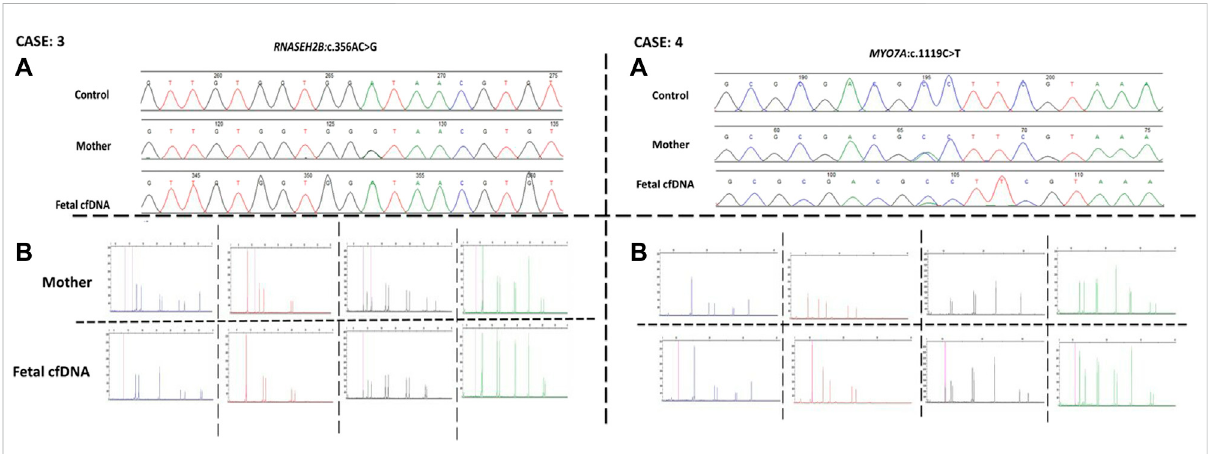
FIGURE 3 Case3andcase4 fi ndings. (A) Sangerresultsfor RNASEH2B, and MYOA7A genesrespectively,forthemothersandWGAproductsofcffDNA. (B) AmpFLSTR ™ Identi fi ler ™ Plus kit results for the mothers and WGA product of cffDNA to detect maternal